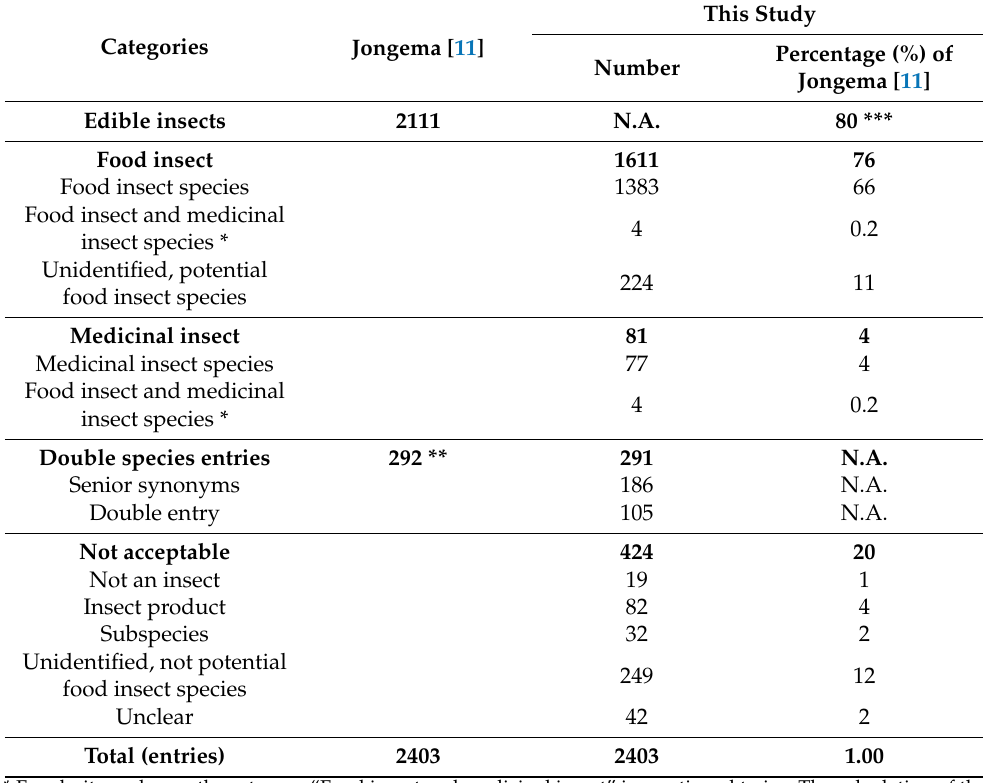
Table 1. Categorization of Jongema’s [11] list entries and a comparison of edible insect species estimates between Jongema [11] and this study. N.A. = not